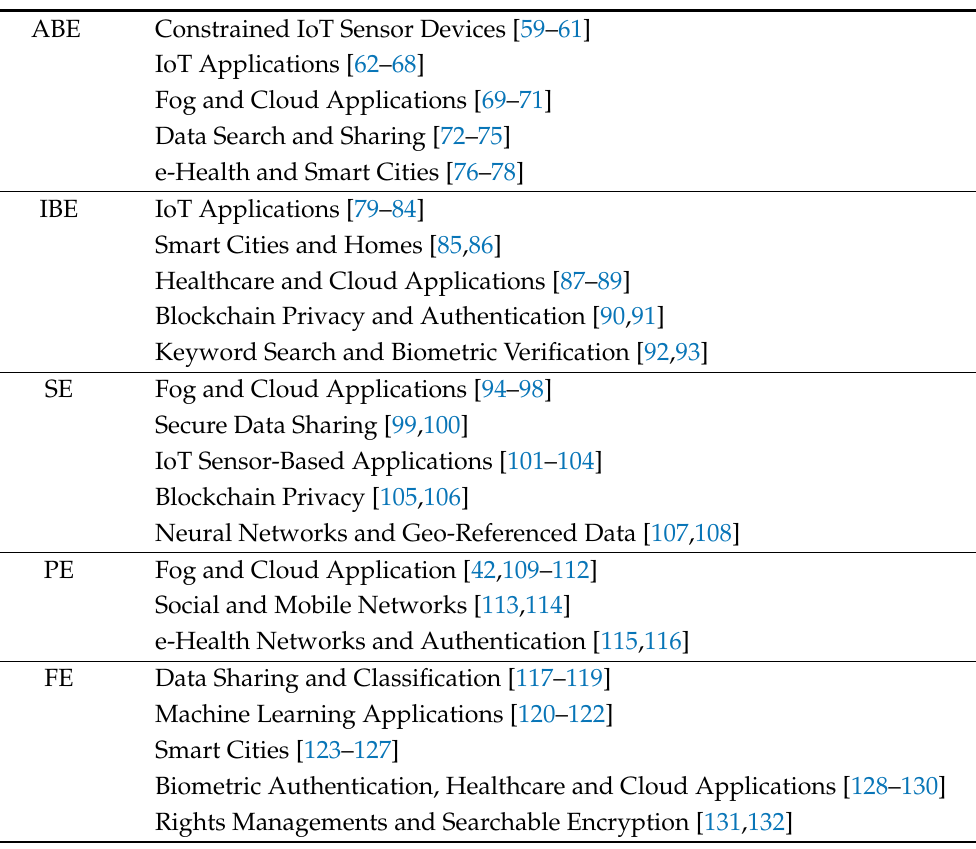
Figure 11. Smart cities are perceived to improve the overall quality of life for their citizens. Table 1. An overview of the representative literature discussed in this